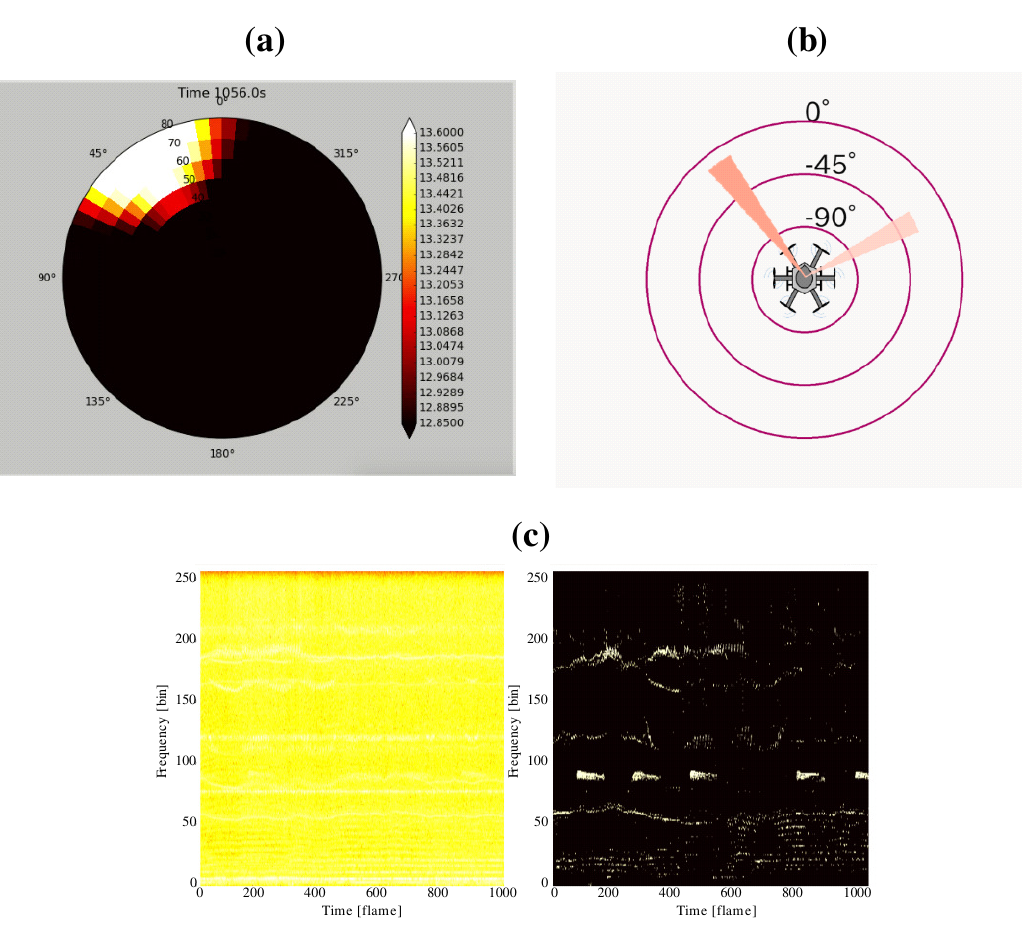
Figure 8. Visualization tools. ( a ) MUSIC spectrum; ( b ) sound direction; ( c ) spectrograms of captured sound ( left ) and after enhancement ( right